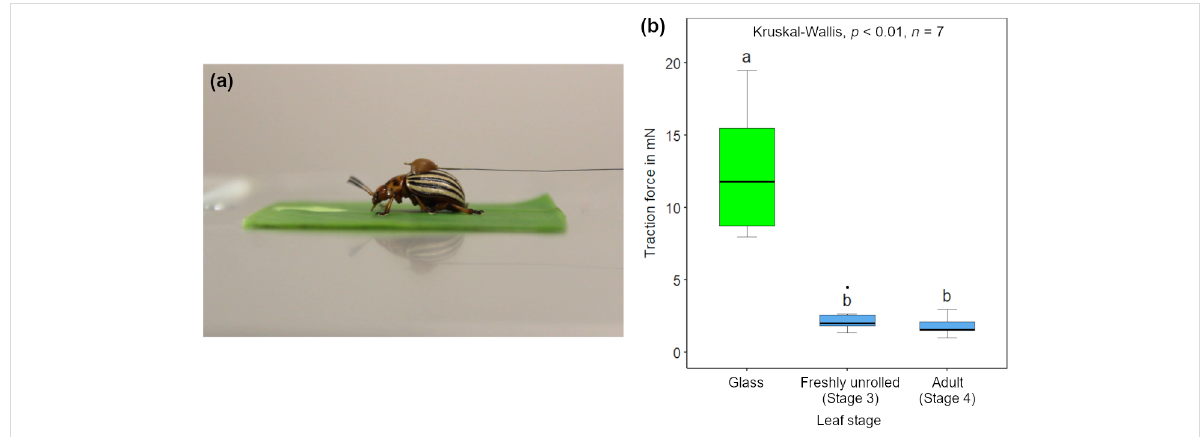
Figure 6: Insect traction forces: (a) A female Colorado potato beetle walking on a Schismatoglottis calyptrata leaf sample and (b) traction forces (in mN) of female Colorado potato beetles on glass, freshly unrolled (stage 3) and adult (stage 4) leaf samples ( n = 7).